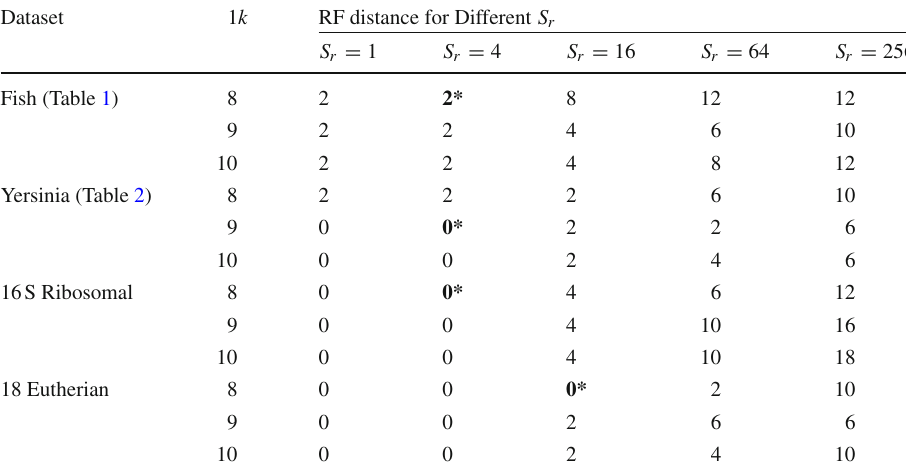
Table 3 k and S r selection using four datasets